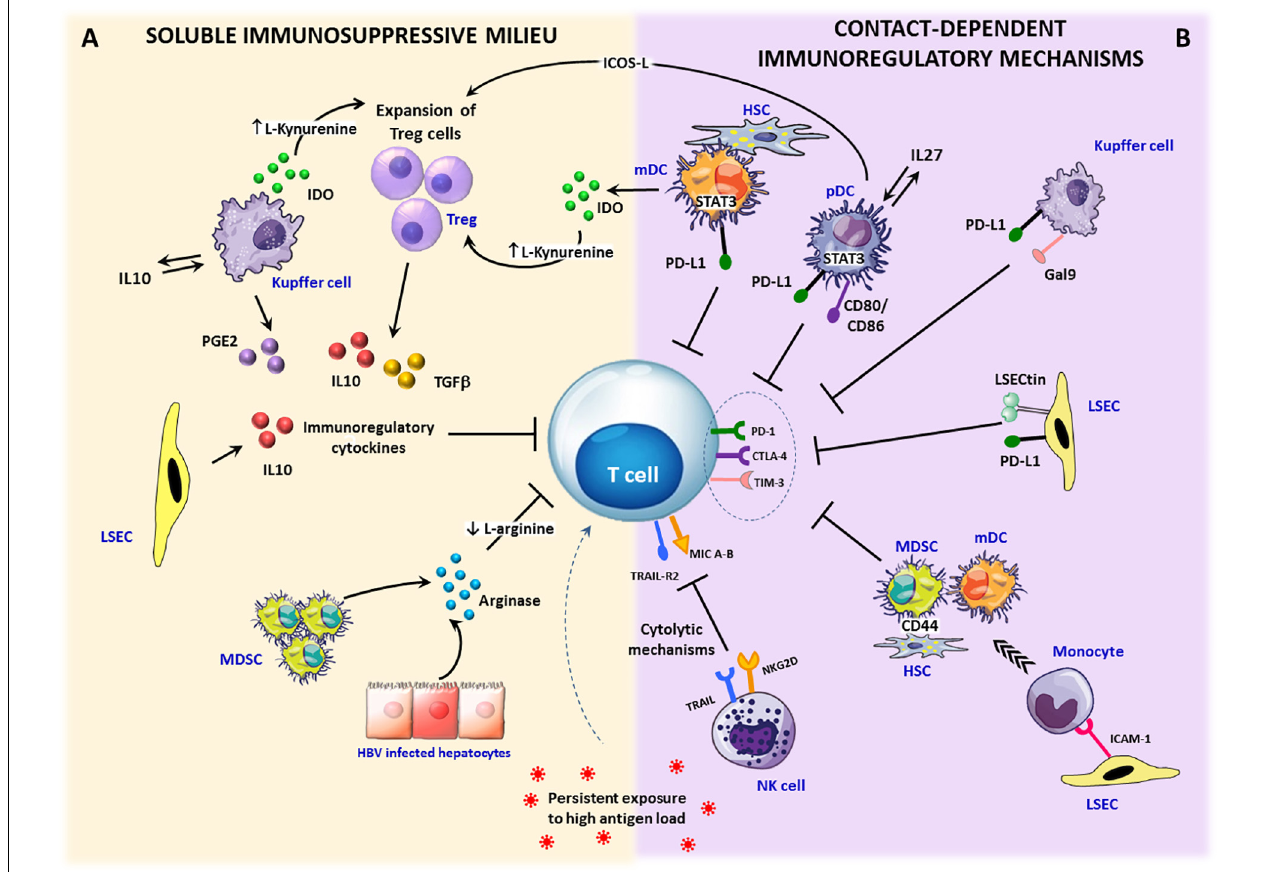
FIGURE 2 | Immunosuppressive circuits in the liver. Within the infected liver, persistent expression of viral antigens in concert with different immunoregulatory pathways drive T cell differentiation toward exhaustion. Upon inflammation, IFN- γ stimulation activates immunosuppressive mechanisms that can be mediated by soluble factors or require cell to cell contact. (A) Soluble factors: immunosuppressive cytokines, such as TGF- β and IL-10 can be produced by expanded regulatory T cells (Treg) as well as by stellate cells (HSCs), dendritic cells (DCs) and Kupffer cells (KCs). In addition, a number of liver infiltrating cells, such as monocytes, macrophages and dendritic cells, can release the tryptophan-degrading enzyme indoleamine 2,3-dioxygenase (IDO), which causes either tryptophan depletion with consequent dampening of T cell proliferation and function or the generation of toxic catabolites, such as kynurenines, which can cause T cell apoptosis and CD4 differentiation in Treg cells. Another key soluble mediator is represented by arginase, released by damaged hepatocytes and myeloid-derived suppressor cells (MDSC), inducing arginine depletion. Lack of arginine determines CD3 ζ downregulation and suppression of T cells proliferation. Moreover, the enzyme cyclooxygenase-2 produced by activated KCs participates in the synthesis of the immunosuppressive prostaglandin E2 (PGE-2). (B) Contact-dependent mechanisms: antigen-specific CD8 T cells can be killed by NK cells through NKG2D- and TRAIL-dependent lysis. Over-expression of inhibitory ligands (e.g., PD-L1, Galectin-9) on liver endothelial sinusoidal cells (LSECs), dendritic cells, KCs, and stellate cells facilitates the triggering of T cell inhibitory pathways. In addition, inflammatory monocytes recruited into the liver through ICAM-1 expression on LSECs can differentiate into myeloid-derived suppressor cells by a